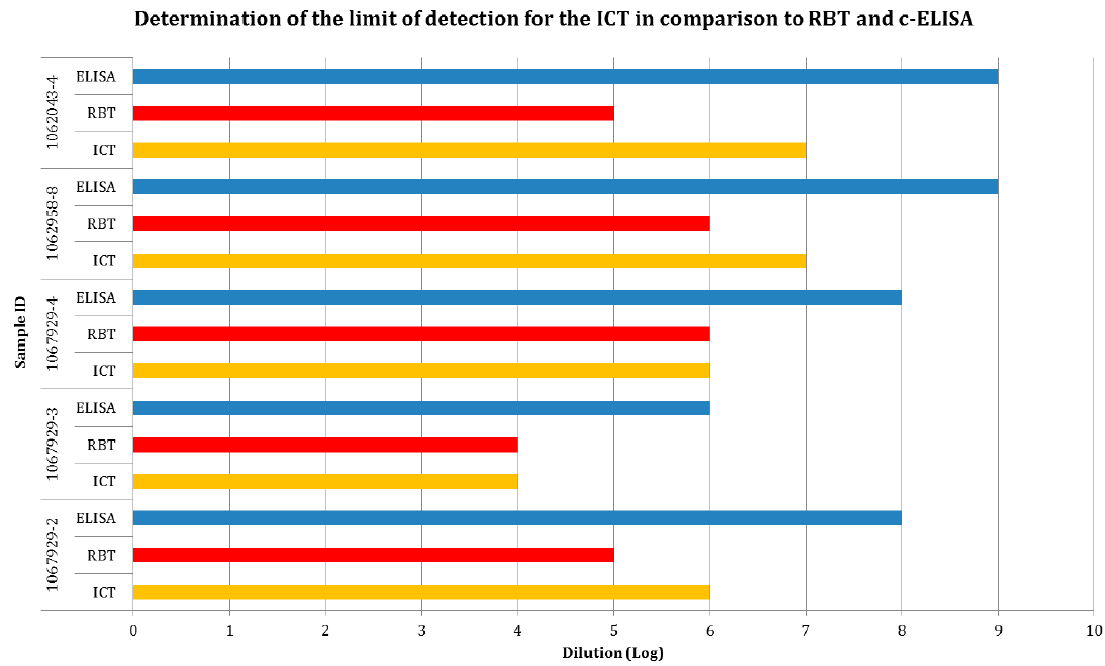
Figure 3. Determination of the limit of detection for the Immunochromatographic Test (ICT) in comparison to Rose Bengal Test (RBT) and c-ELISA.